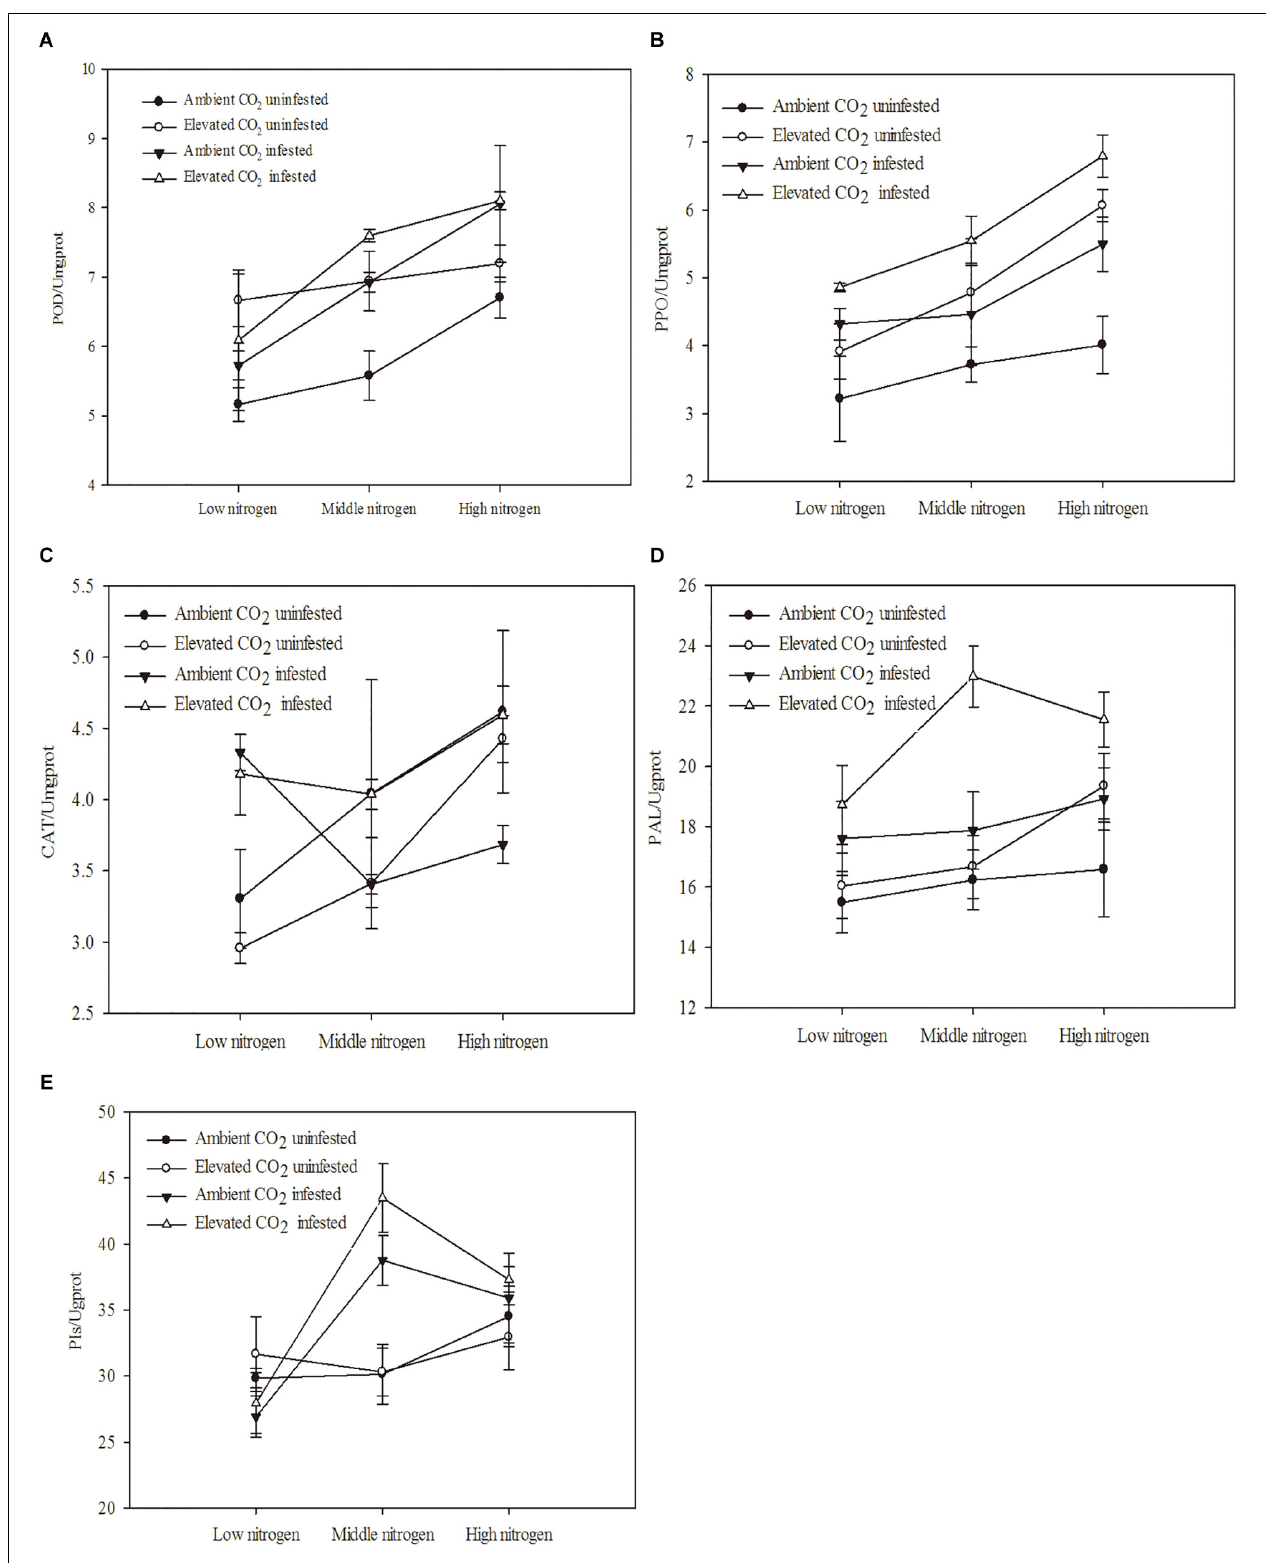
FIGURE 3 | Defensive response of mazie grown under different levels of CO 2 and nitrogen fertilization conditions (mean ± SE, n = 3). (A) Peroxidase (POD) activity, (B) polyphenol oxidase (PPO) activity, (C) catalase (CAT) activity, (D) phenylalanine ammonia-lyase (PAL) activity, and (E) proteinase inhibitors (PIs).